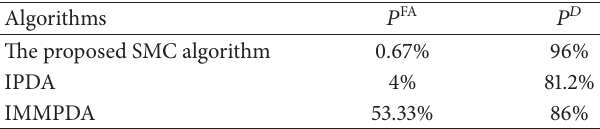
Table 2: Detection performance comparison.